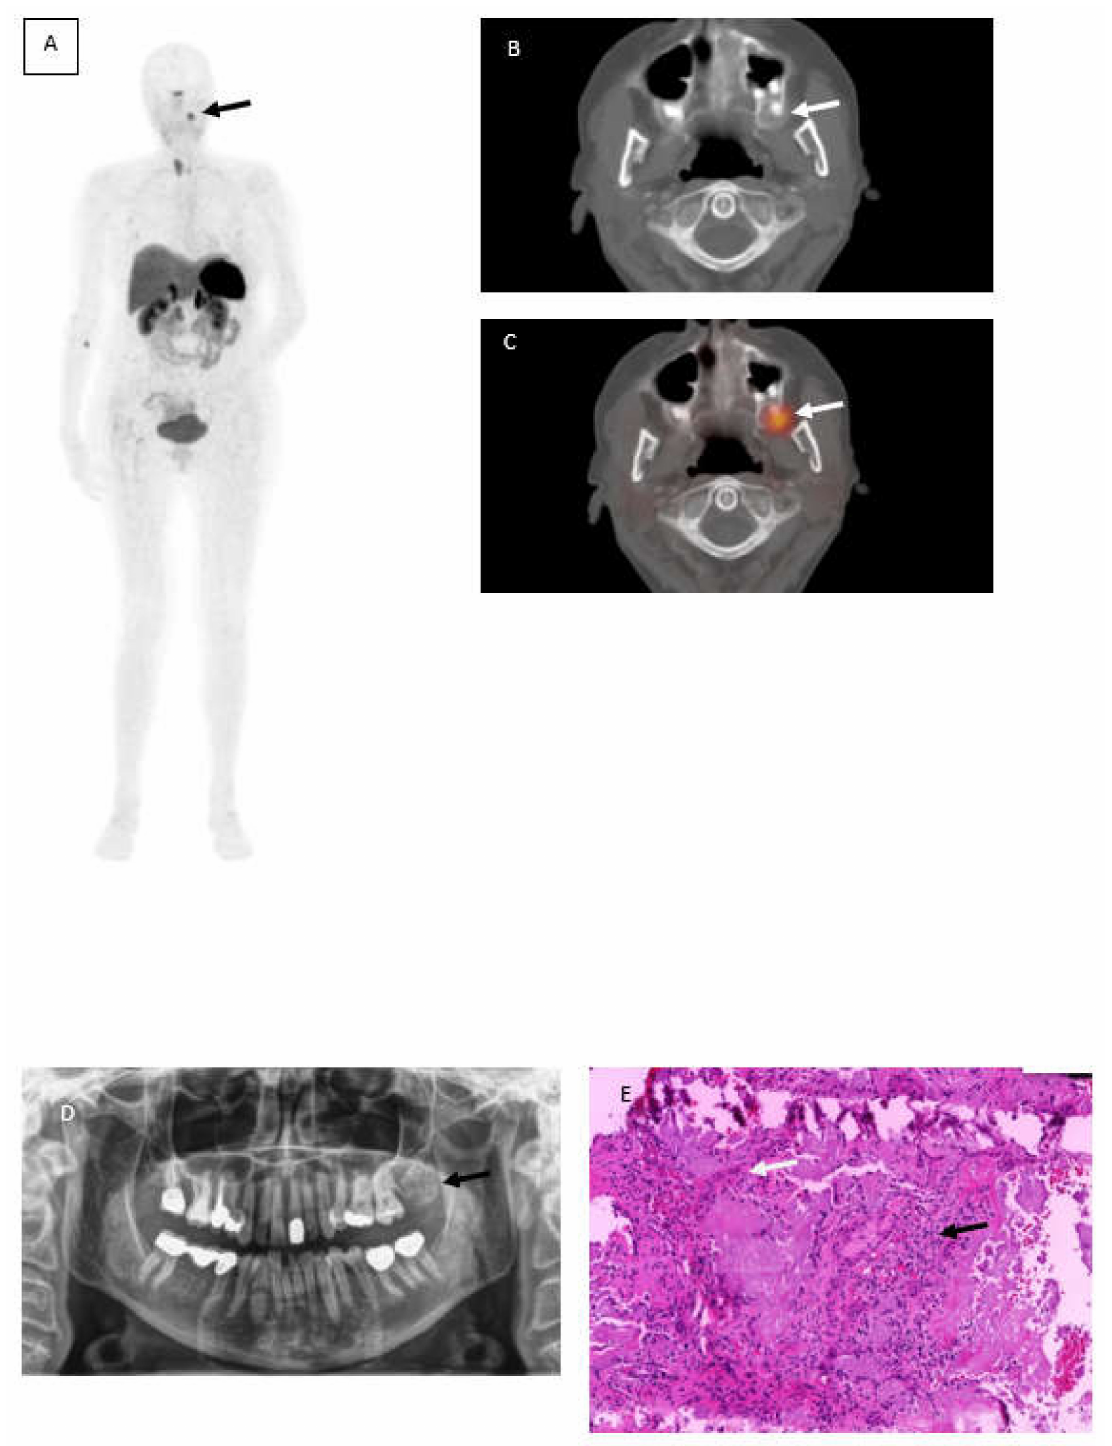
Figure 1. 68 Ga-DotaTOC PET/CT showing focally increased tracer uptake maxillary left ( A ) black arrow corresponding with a well circumscribed radiopaque area ( B , C ) white arrows. Orthopan- tomogramm shows a mixed radiopaque, well-defined mass at corresponding location ( D ) and histopathological photograph ( E ) hematoxylin and eosin-stained sections revealed several panCK positive sheets of eptithelial cells (black arow) interspersed with eosinophilic amyloid-like material (white